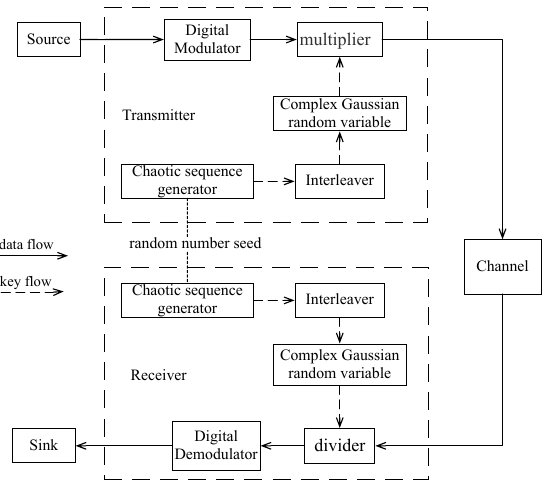
Figure 1. Block diagram of the proposed secure communication system with artificial Rayleigh fading and two-stage block interleaver (baseband